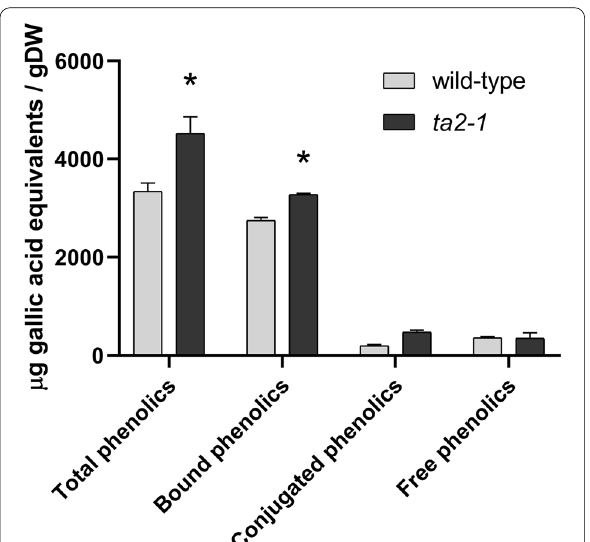
Fig. 7 Phenolics composition of total, bound, conjugated, and free phenolics comparison (* P < 0.05; ANOVA, Tukey’s HSD test; total, bound, conjugated, and free phenolics, n 3, except wild‑type = conjugated phenolics, n 2) =